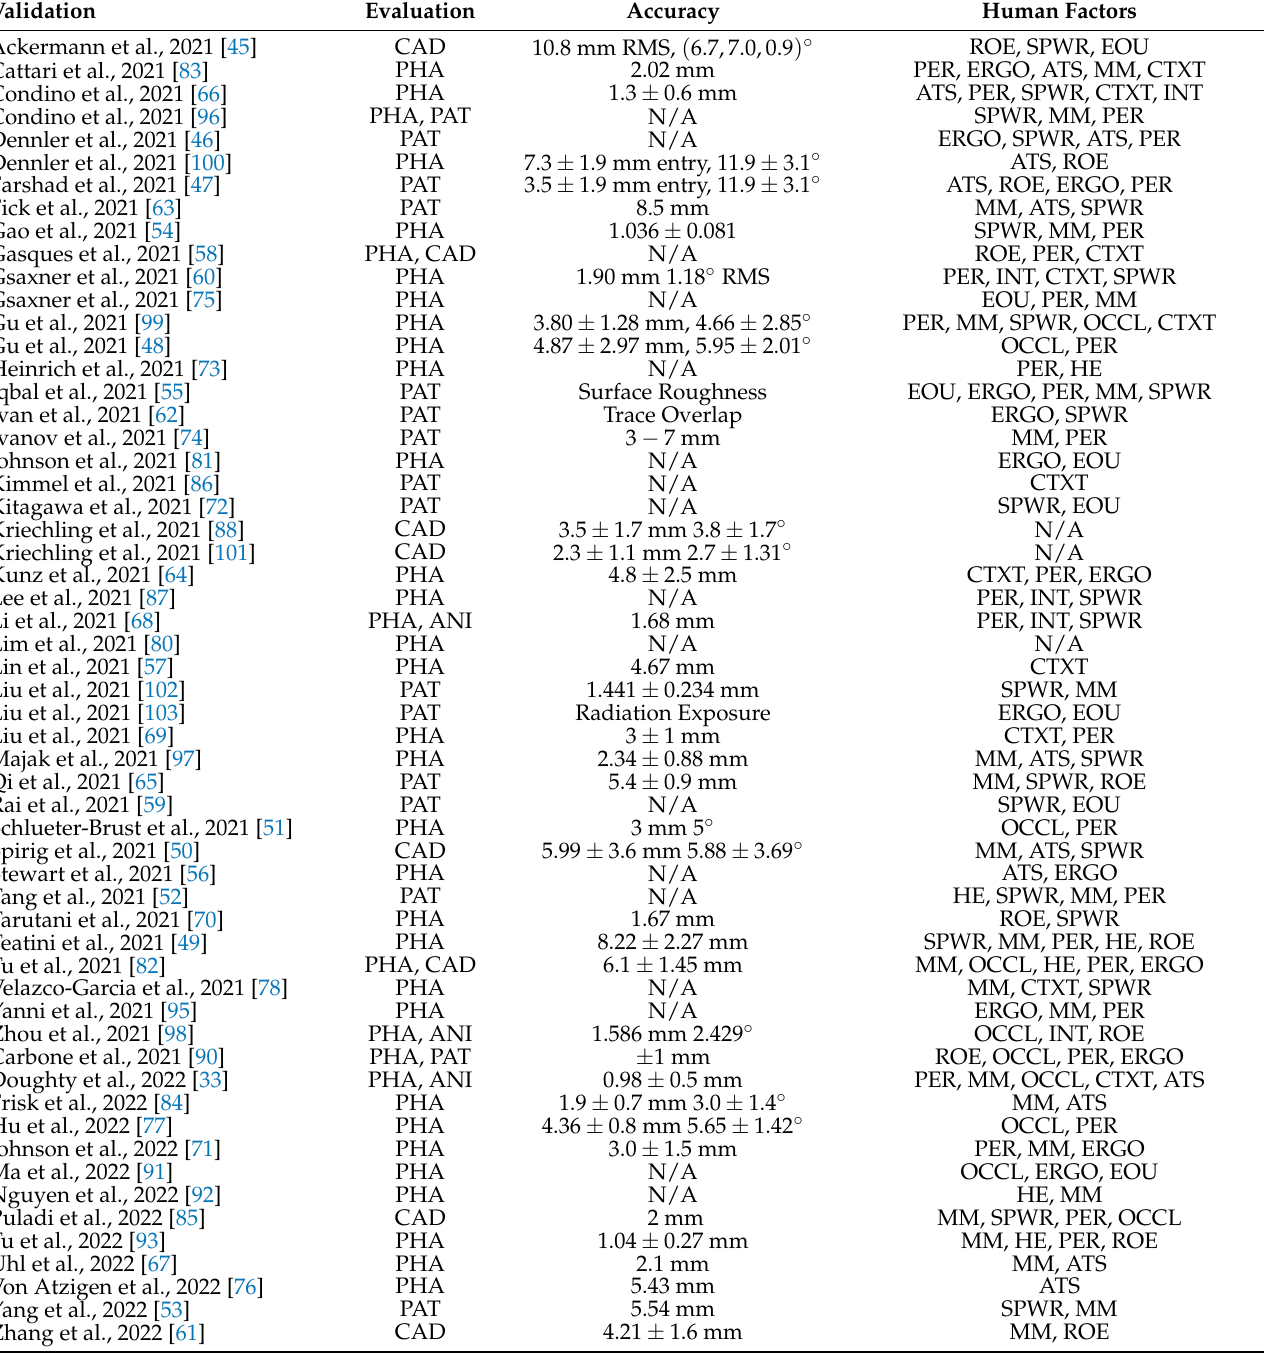
Table 6. Papers categorized by the validation type employed. Models for evaluation included phantom models (PHA), cadaver models (CAD), animals (ANI), and patients (PAT). Human factors considerations included risk of error (ROE), spatial awareness (SPWR), ease of use (EOU), perception (PER), ergonomics (ERGO), attention shift (ATS), interaction challenges (INT), mental mapping (MM), context (CTXT), hand-eye coordination (HE), and occlusion (OCCL). Not applicable (N/A) methods are